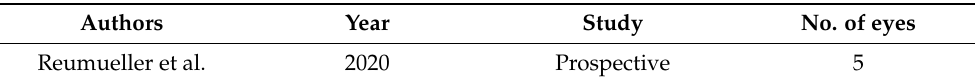
Table 5. Adaptive optics